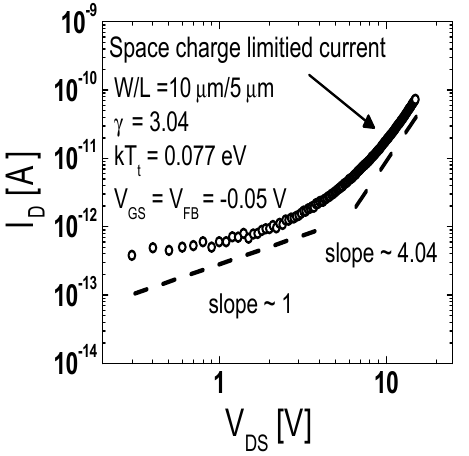
Figure 7. Log–log plot of the I D – V DS curve measured from the fabricated IGZO TFT under the flat-band condition.